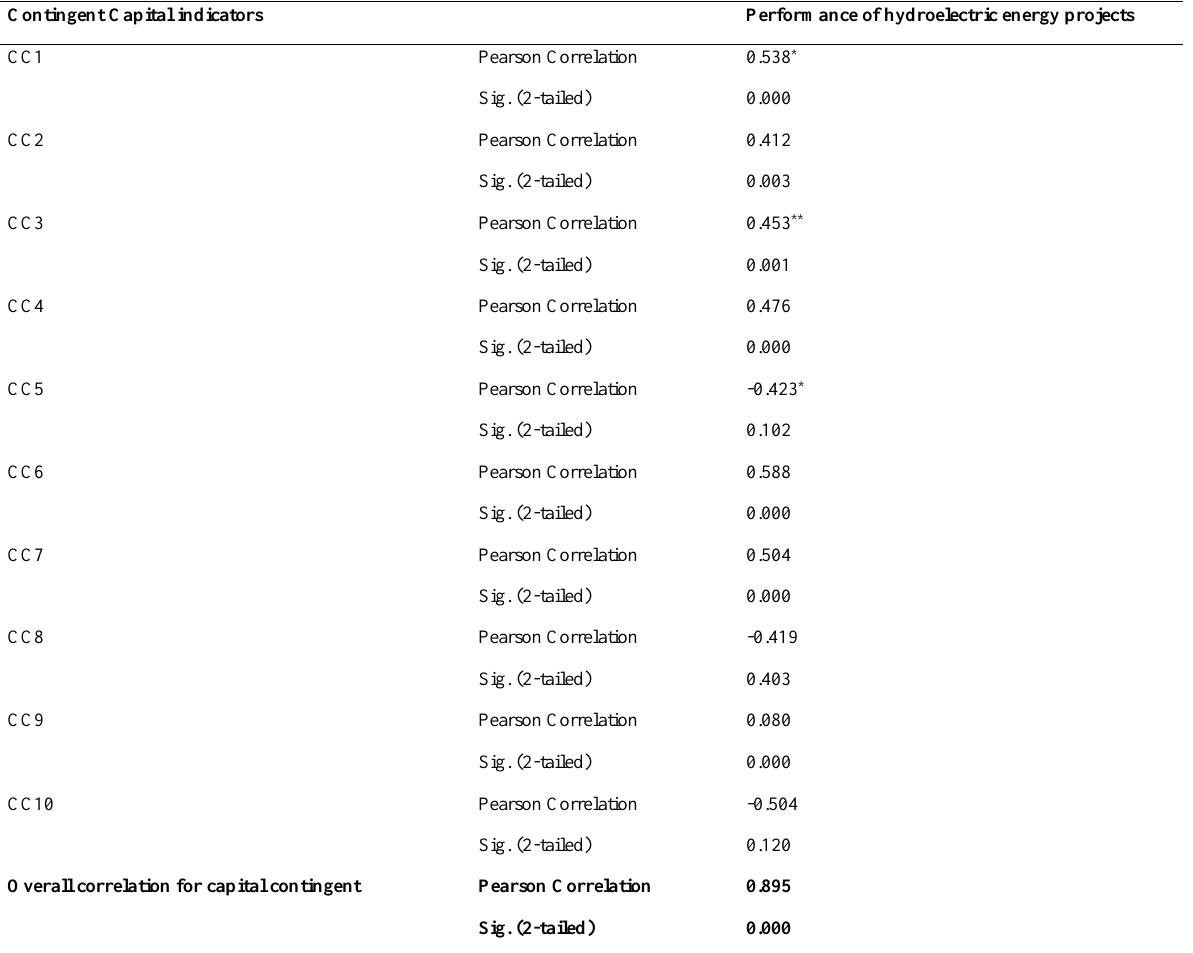
Table 2: Correlations of Capital Contingent and Performance of Hydroelectric Energy Projects (n=84); NB *